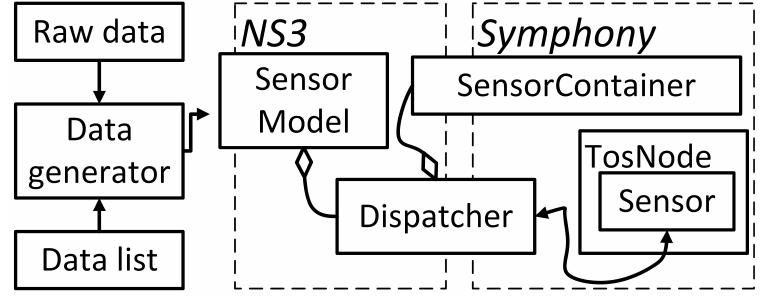
Figure 10. Architecture of the Data Feed scope that supports the sensor